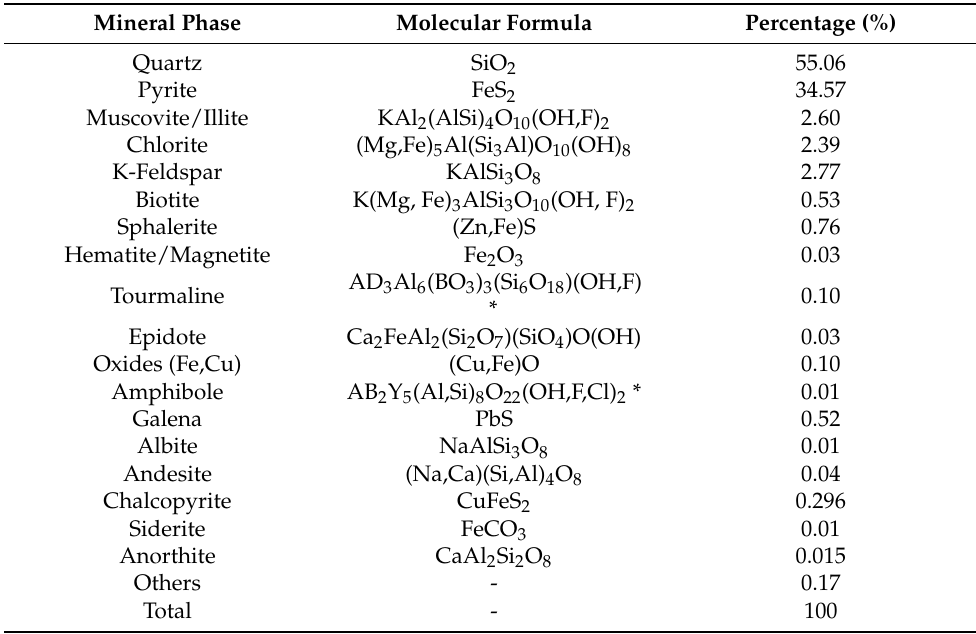
Table 5. Mineralogical composition of the tailing sample by automated mineralogy on TESCAN.